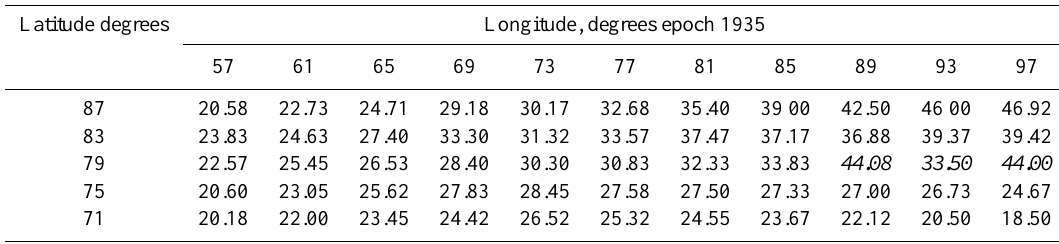
Table 2. Values of D at the nodes of the grid with a spacing of 4 ◦ according to the data of B. P. Weinberg and I. M. Rogachev (1933) for the epoch 1935 in the Arctic region. The anomalous values of D are given in italics. Latitude